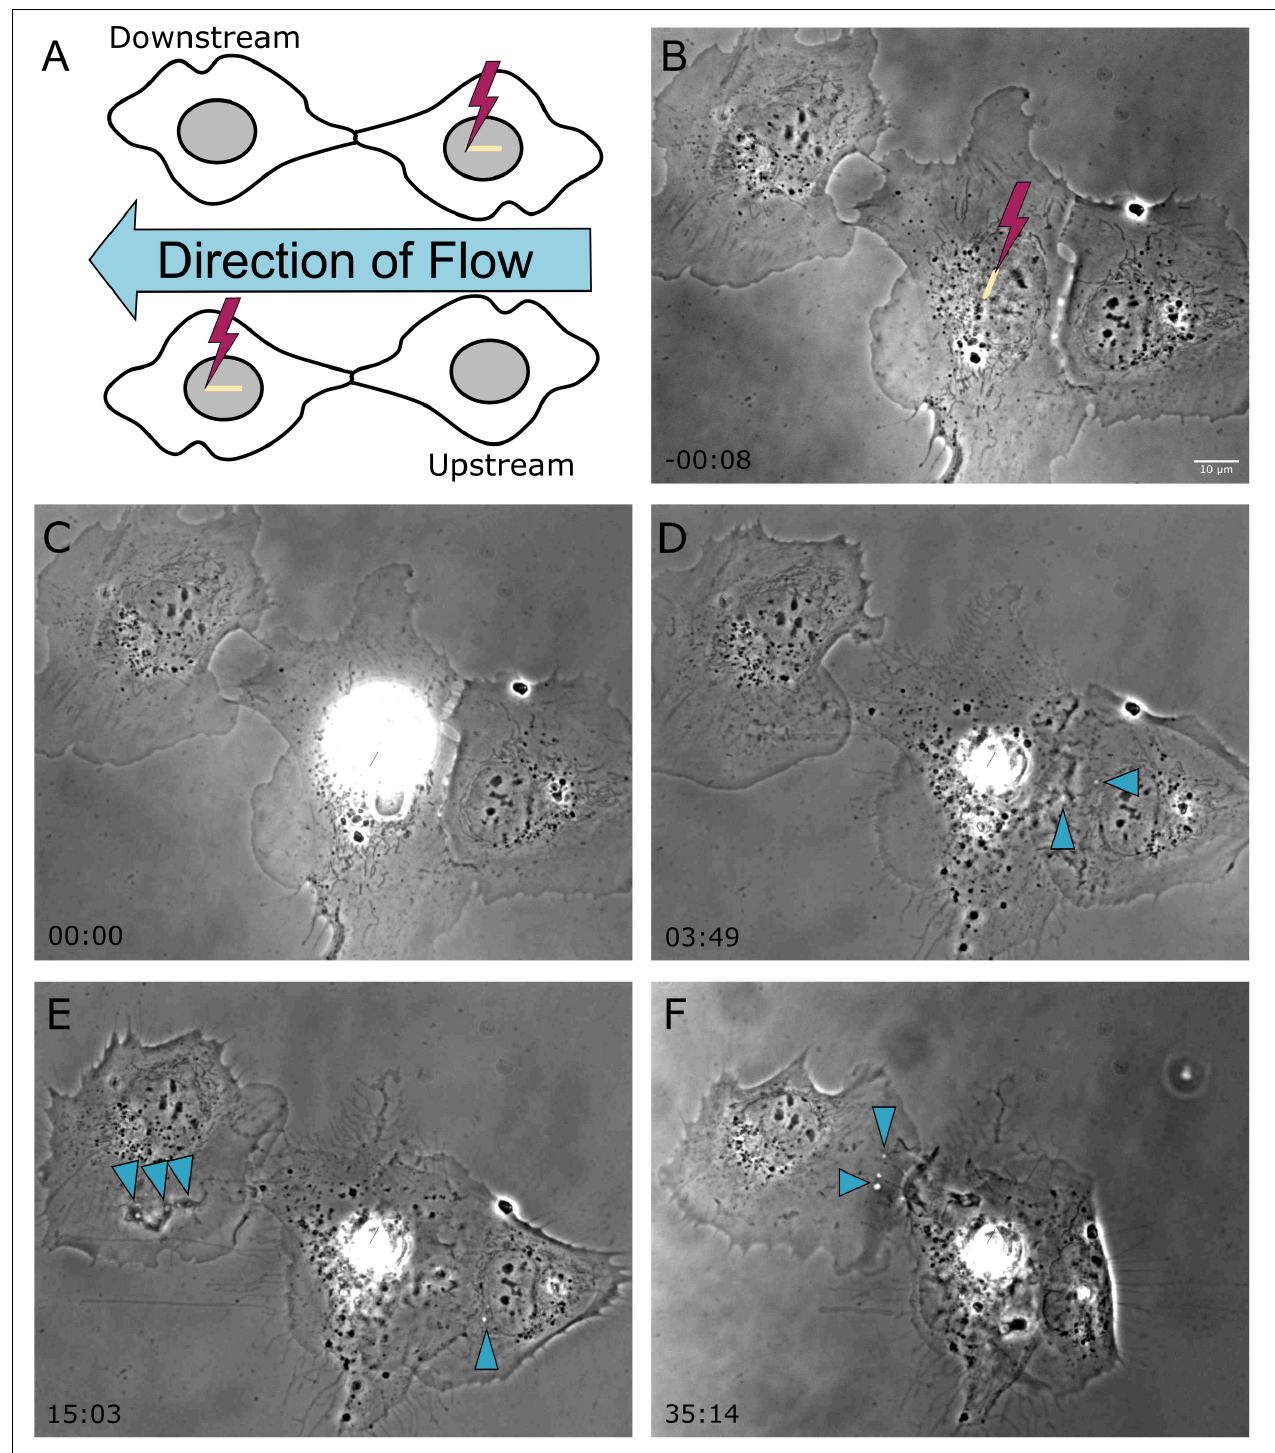
FIGURE 1 | Shear stress was applied laterally from right to left on cells located horizontal to one another, as depicted in the schematic diagram in frame (A) . The cell located on the left is downstream of the irradiated cell, and the cell located on the right is upstream of the irradiated cell with respect the applied flow. (B) Prior to photolysis, astrocytes display no to minimal vesicles. The position targeted by the laser is depicted by the yellow ROI. (C) The laser is targeted to the nucleus of the central astrocyte as media flows laterally across the cells. (D–F) Phase contrast images show that the upstream cell initiated phagocytosis earlier than the downstream cell, as visible by cell ruffling and endocytic vesicle formation in image (D) acquired 3 min 49 s following photolysis for the downstream cell, and image (E) acquired 15 min 3 s for the upstream cell. Blue arrows highlight endocytic vesicles in phase contrast images of responding astrocytes.